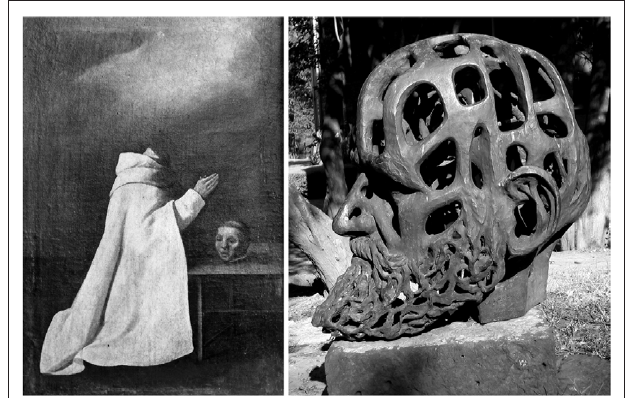
Figure 1 | The mind–body problem. Left: Fray Pedro de San Dionisio, painted by Francisco de Zurbarán (1598–1664). © Fundació Institut d’Art Hispanic Amatller. Arxiu Mas. Right: Don Quixote, Museum of Arte Moderno in Mexico. These images are examples of the separation between the mental and the physical worlds. The saint levitates while praying, and his head is separated from his body; Don Quixote appears reflective, with an empty head.